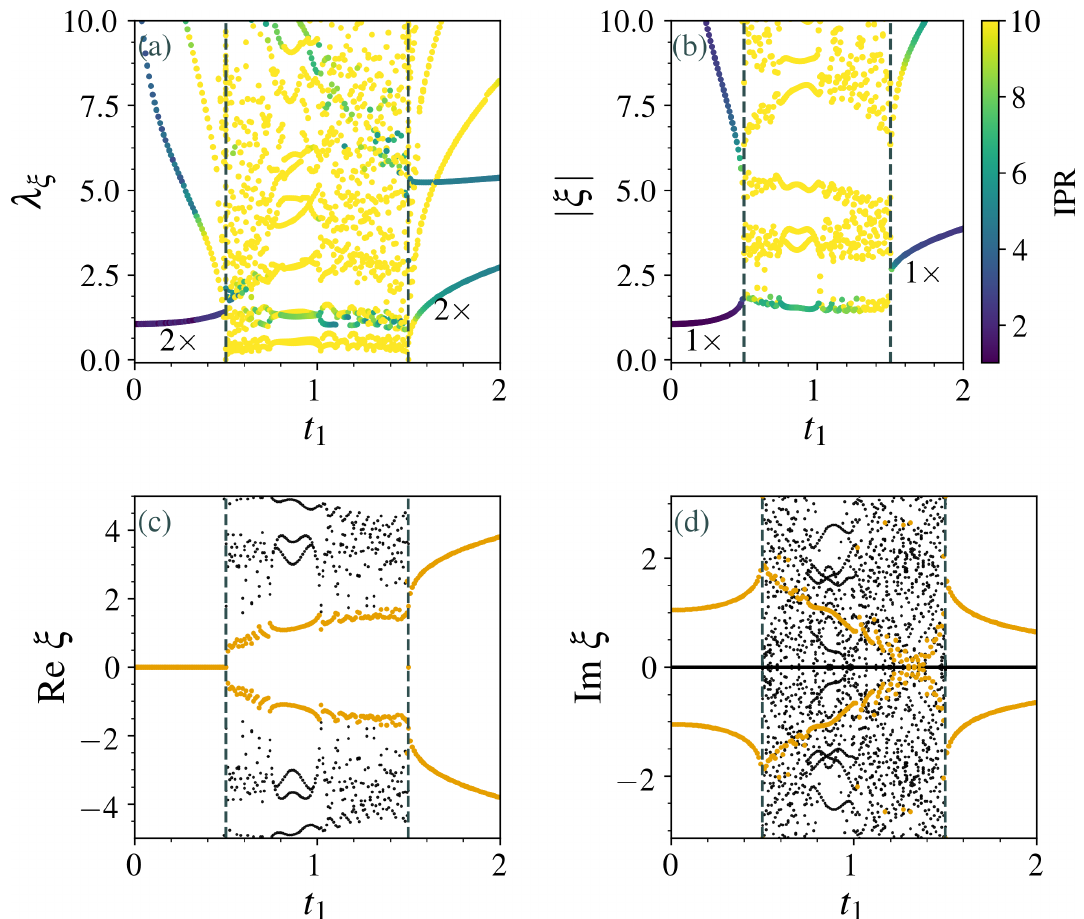
Figure 6: Singular values (a) and eigenvalues (b-d) of the biorthogonal entanglement Hamiltonian H RL as a function of t for γ = 0 and µ = 0.5. The total system is of 1 E length L = 201 and we consider a subsystem of size l = 40 unit-cells. In (a-b), colors represent the bilocalized inverse participation ratio of the corresponding singular modes I PR SVD and of the eigen modes I PR RL (see Eqs. (55) and (55) in App. B). < 1 > 3 The two gapped phases “H-Topo” ( t ) and “H-Triv” ( t ) are separated by 1 1 2 2 the gapless phase “Gapless”. The biorthogonal entanglement Hamiltonian presents a similar phase diagram. The noise in entanglement values is characteristic of finite size-effects in gapless phases. In (c) and (d), we highlight the eigenvalues with lowest absolute real part. In the “H-Topo” phase, we observe purely imaginary eigenstates exponentially localized at each extremity of the subsystem. The phase transitions are marked by the dashed vertical lines, and occur simultaneously for singular values and eigenvalues, at the parameter values predicted by the periodic system. While the corresponding edge states survive in the gapless phase for the OBC system, this is not the case for the entanglement